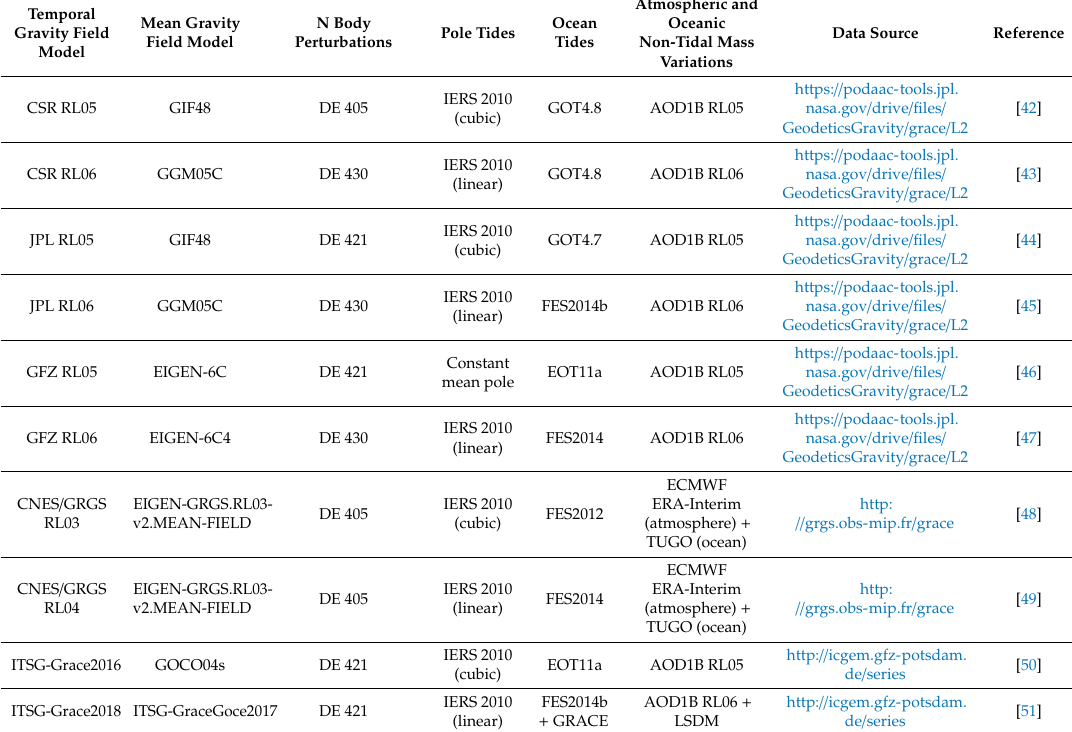
Table A6. Background models and data sources of temporal GRACE gravity field models *. ECMWF, European Centre for Medium-Range Weather Forecasts; ERA, ECMWF